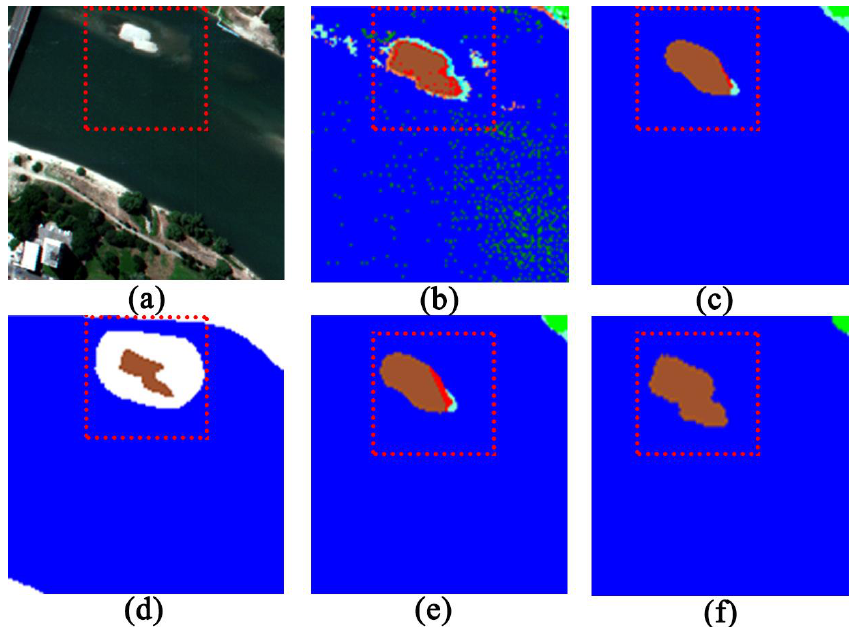
Figure 8. Zoomed comparisons based on the subfigures: ( a ) Pavia Center image, ( b ) initial classified map based on RGV spatial–spectral method and SVM classifier, ( c ) post-classification map obtained by GPCF with a 9 × 9 window size, ( d ) ground reference data, ( e ) post-classification map acquired by majority voting with a 9 × 9 window size, and ( f ) post-classification map acquired by the proposed D-AMVS with 𝑇 1 = 70 and 𝑇 2 = 80 .